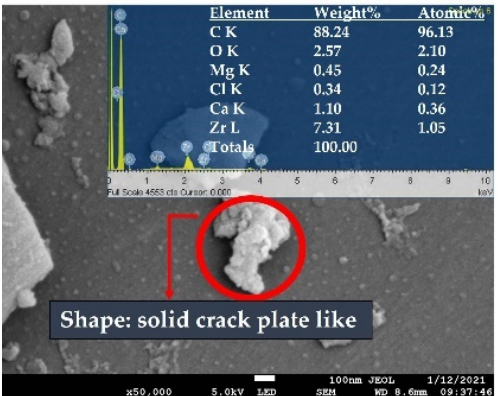
Figure 5. Surface morphology of woodchip biochar before calcination.